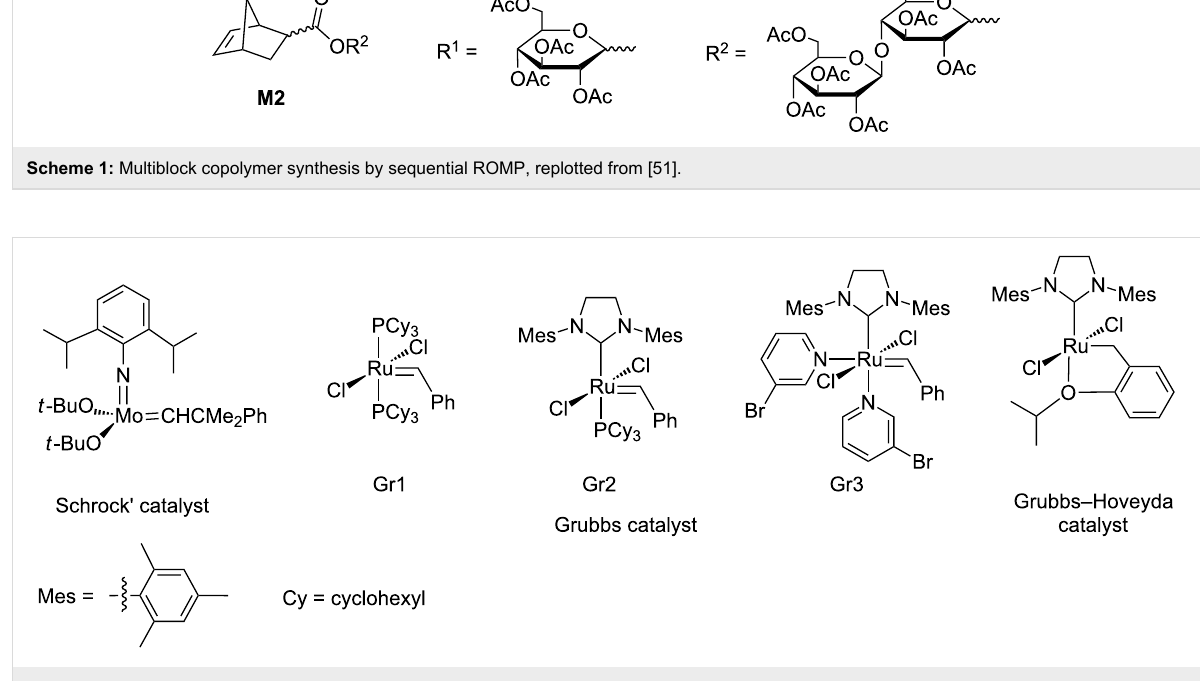
Figure 1: The most known commercially available catalysts for olefin